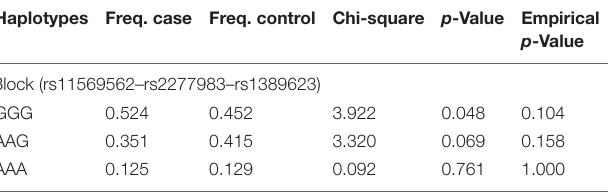
TABLE 3 | Comparison of haplotype frequencies at the C3 gene between FEP and